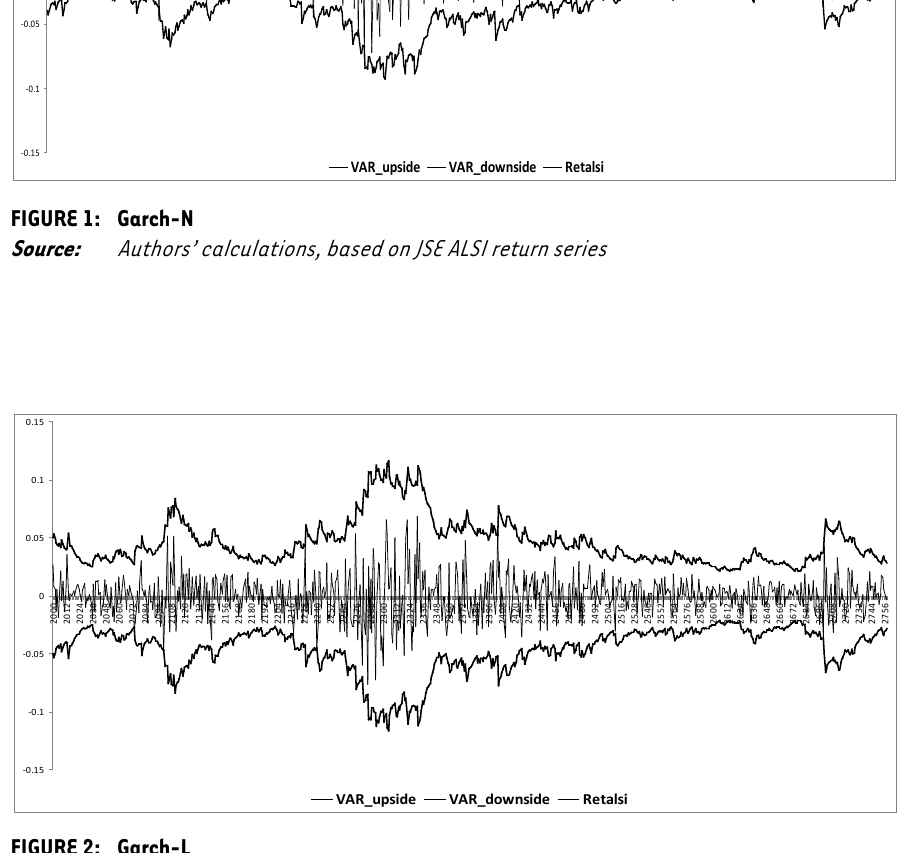
FIGURE 2: Garch-L Source: Authors’ calculations, based on JSE ALSI return